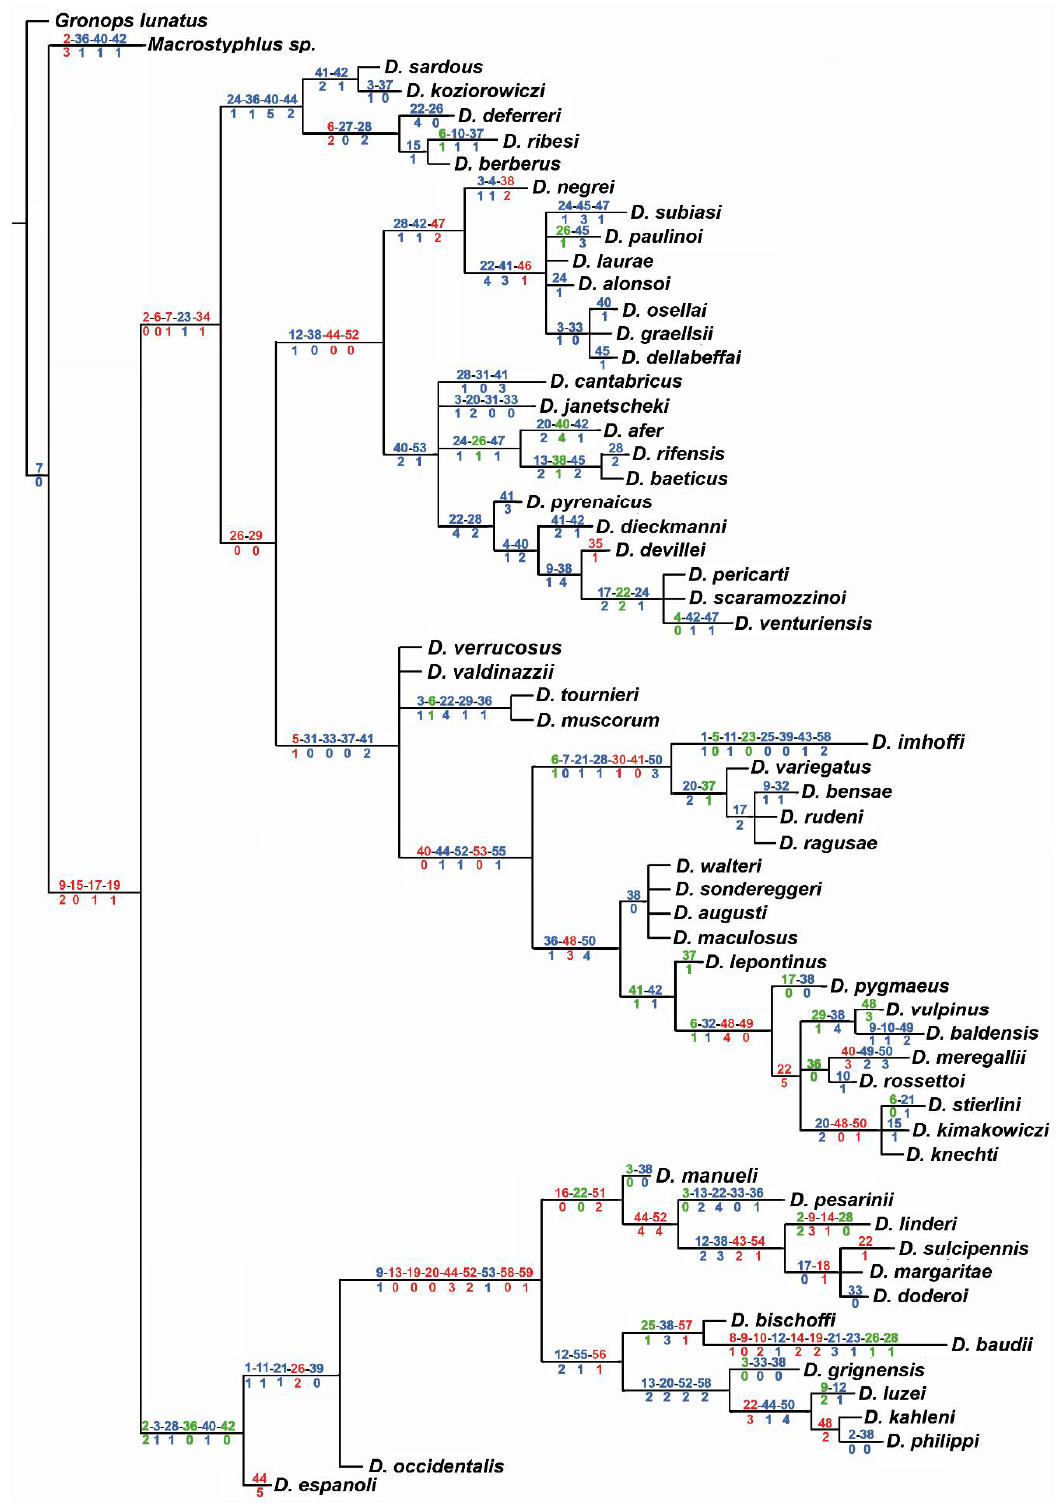
Figure 10. Synapomorphies and autapomorphies plotted on the MP consensus tree. Numbers above branches refer to the character, numbers below branches refer to the state of the character. Characters in red: synapomorphies and autapomorphies unique for the Dichotrachelus clade. Characters in blue: synapomorphies and autapomorphies not unique for the clade or the species. Characters in green: apparent